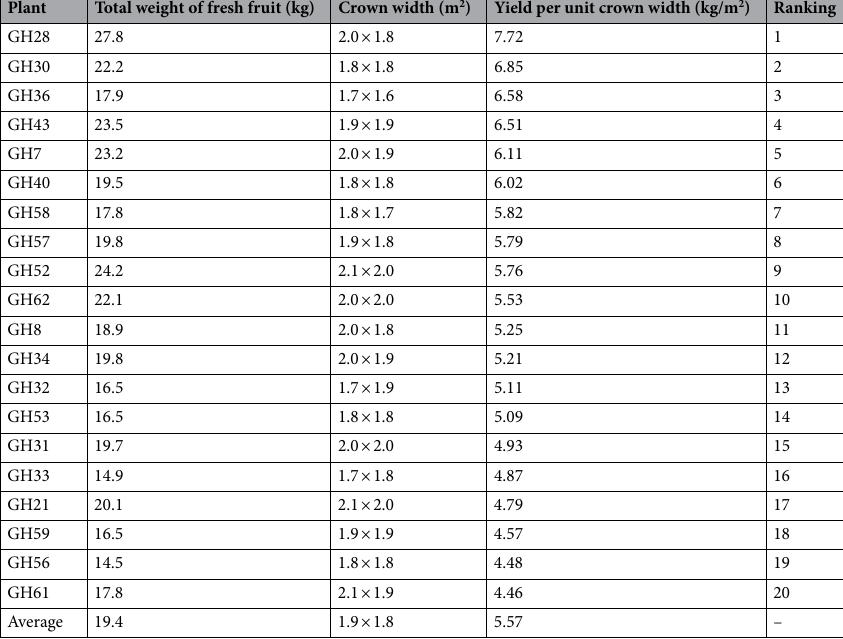
Table 1. Crown width yield and ranking of 20 superior strains of Wangmo red ball Camellia oleifera.